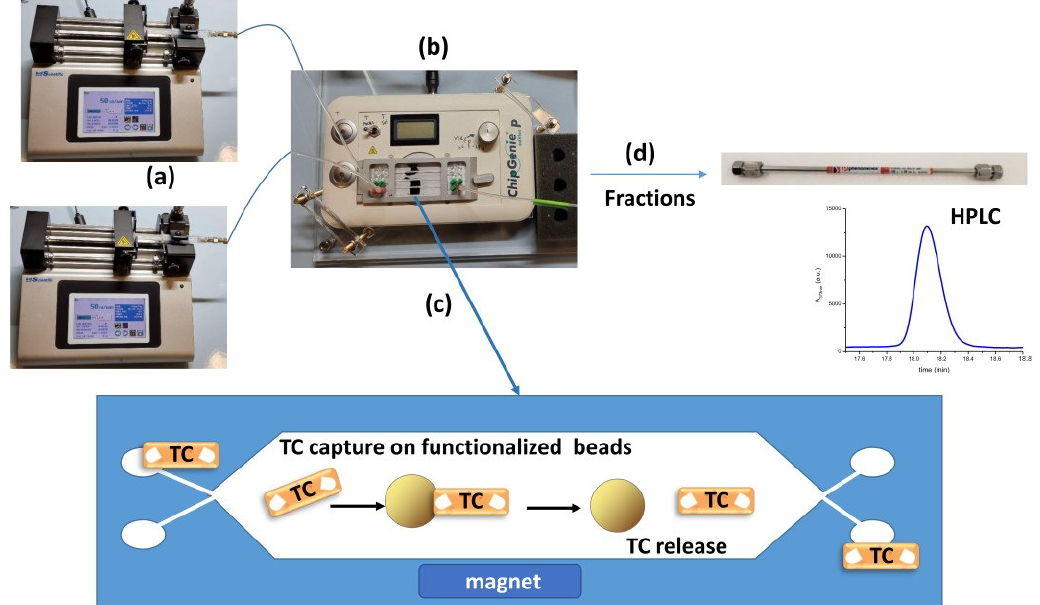
Figure 1. Scheme of the microfluidic purification of antibiotics. Two syringe pumps ( a ) inject the fluids into a microfluidic chip positioned on a device ( b ) equipped with a magnet. The chip, previously filled with the functionalized magnetic microbeads, is fluxed with a solution containing the antibiotics (TC; step ( c )), which are captured by the beads. When a suitable elution solution is fluxed, the antibiotics are released from the beads and collected for analysis with HPLC ( d